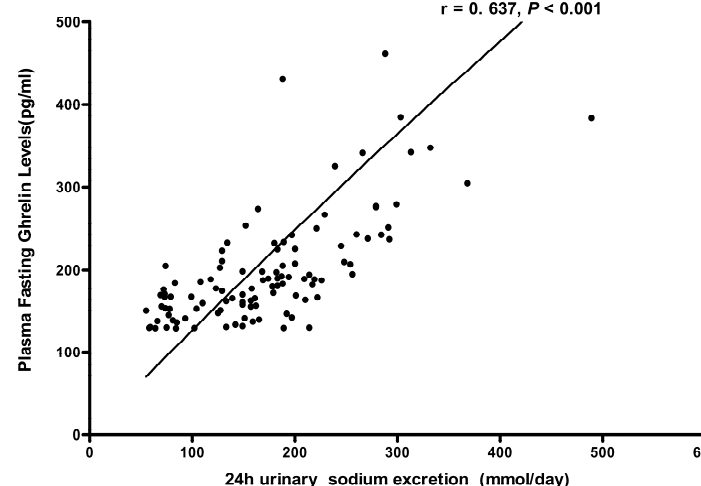
Figure 2. The correlation between plasma ghrelin levels and 24 h urinary sodium excretions in all subjects on baseline, a low-salt diet and on a high-salt